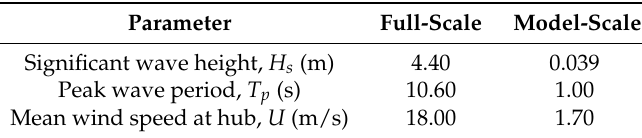
Table 6. Experimental test matrix for regular waves.